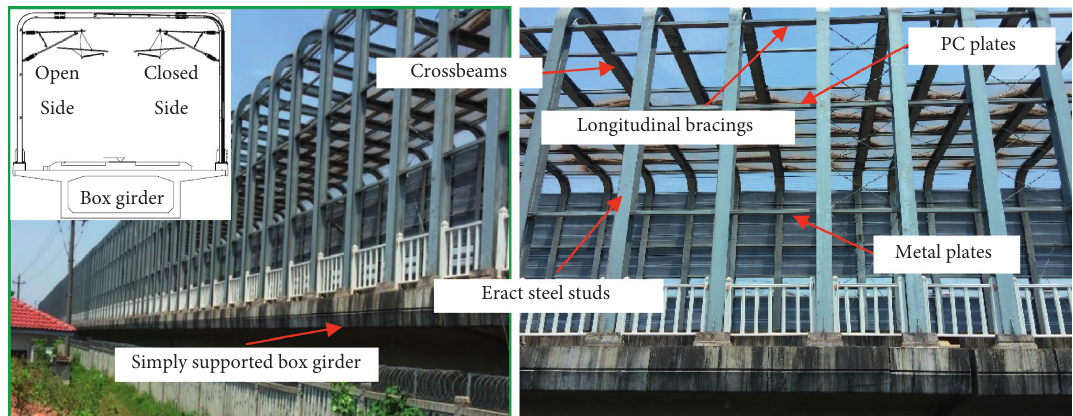
Figure 1: Target semienclosed noise barrier.